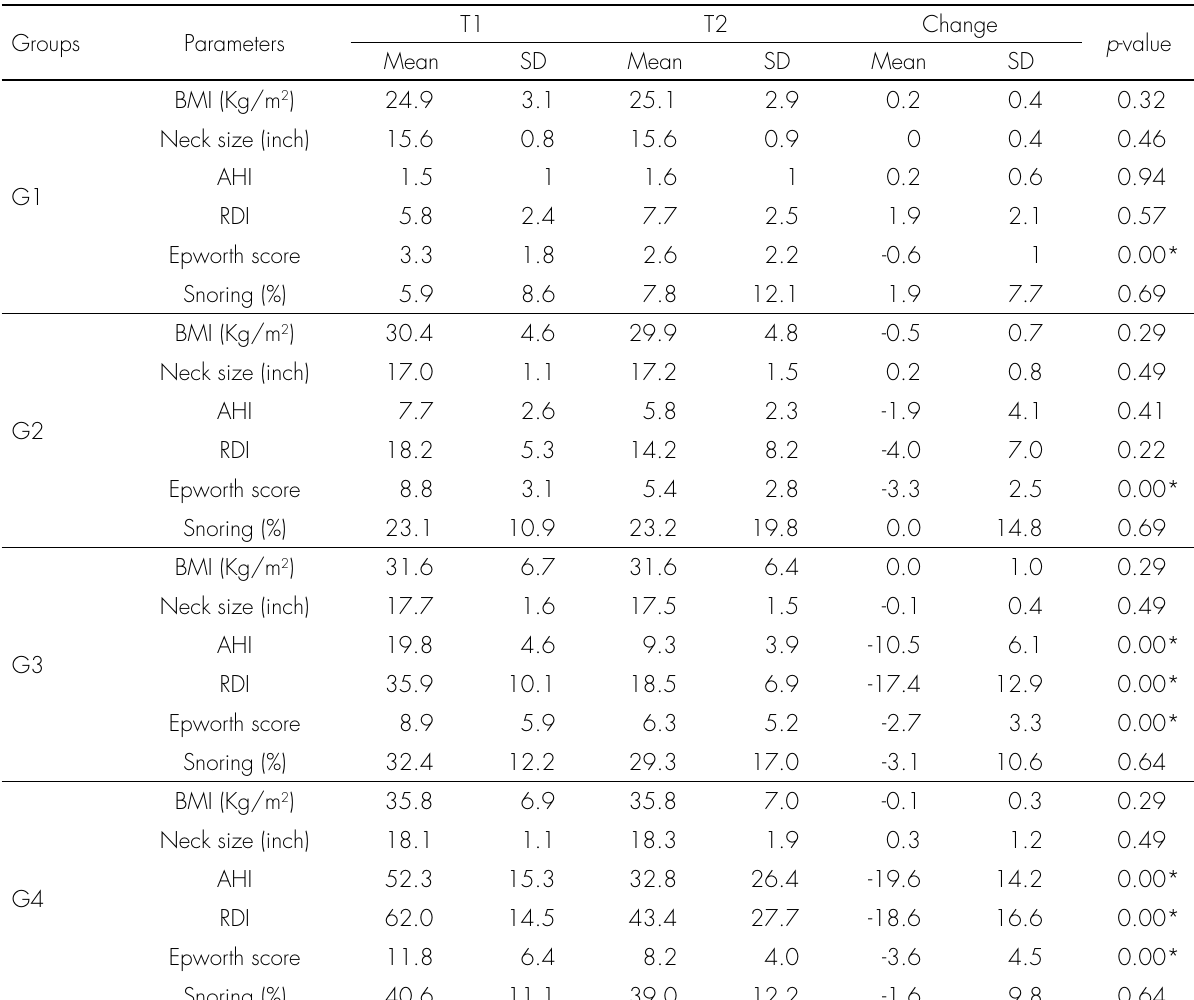
Table III. Comparison of sleep test parameters between T1 and